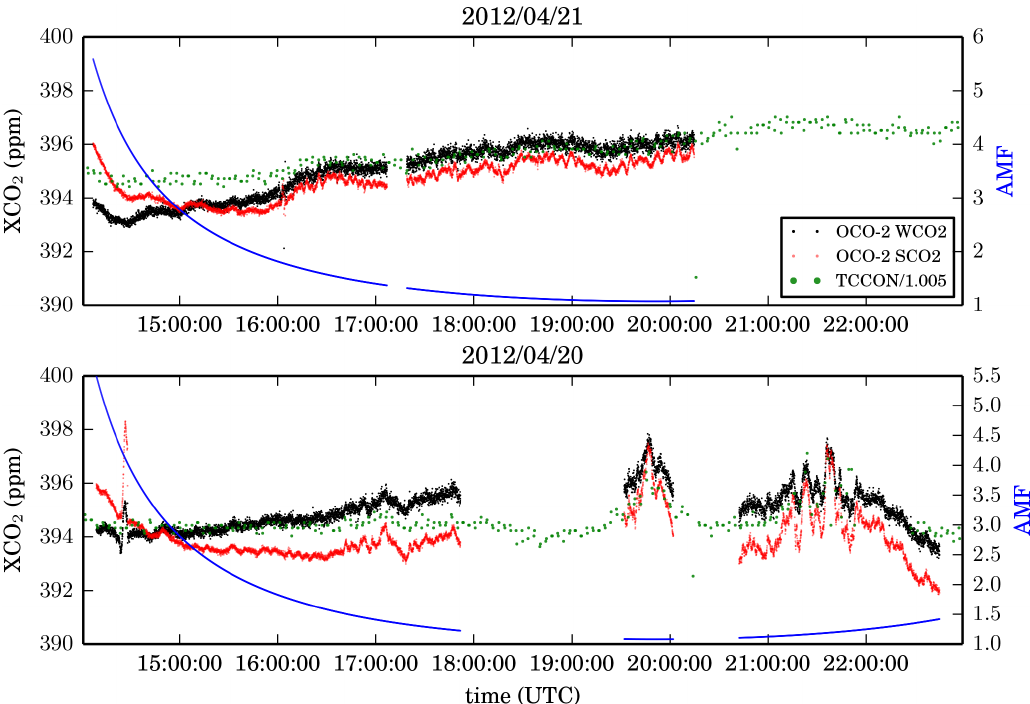
Figure 12. X CO time series on 20/21 April 2012 acquired at JPL near Pasadena, CA. Air mass is depicted in blue, SCO2 and WCO2 results 2 in red and black, respectively, and scaled official TCCON data in green. Only every 10th OCO-2 data point is plotted but all eight footprints are averaged.